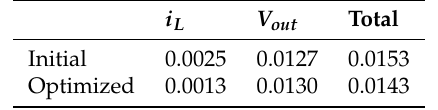
Table 7. ITAE values under the 90 [ Ω ] load test.